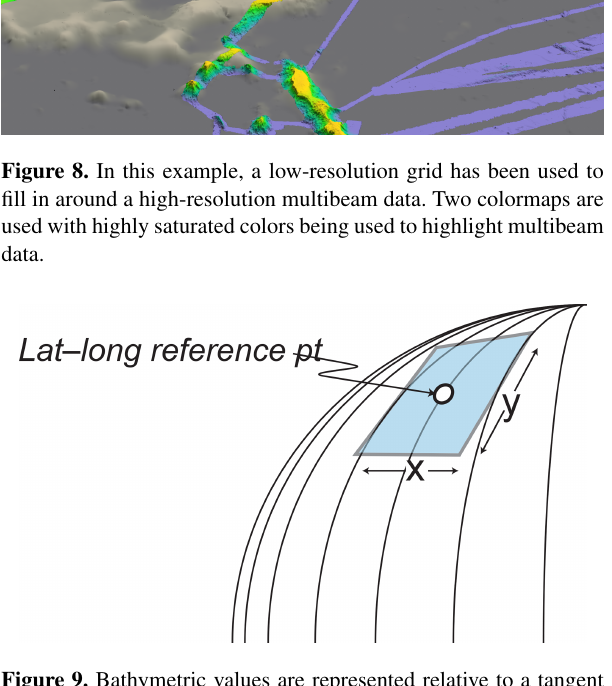
Figure 9. Bathymetric values are represented relative to a tangent plan with an orthographic projection of latitude–longitude posi- tions. Fig. 6c involves obtaining a list of the data grid values along the east edges of the leaf nodes indicated by